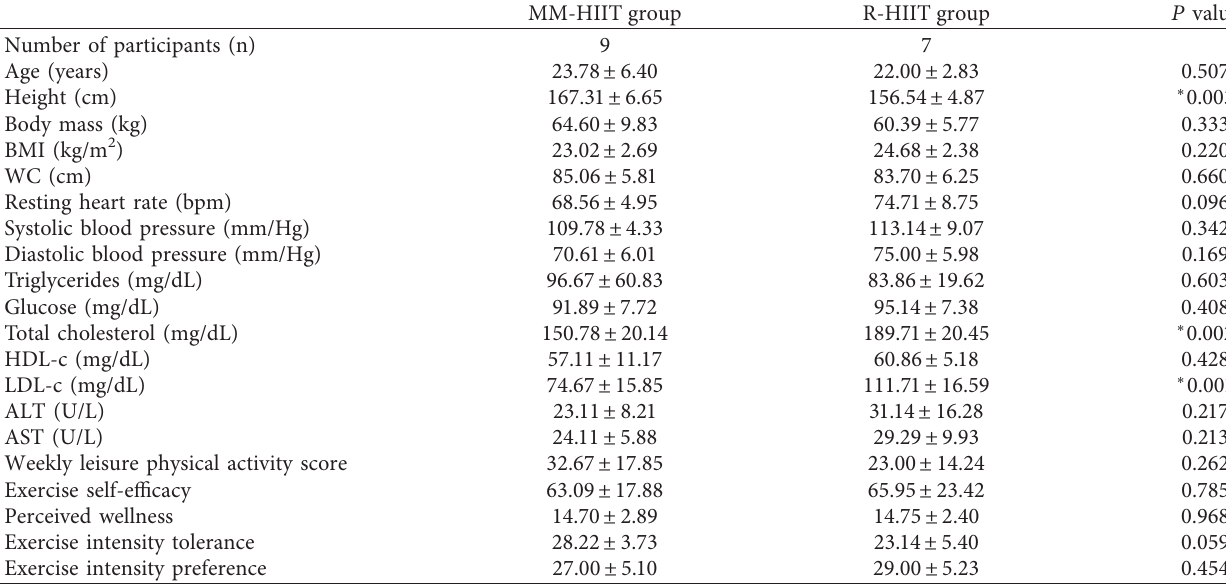
Table 1: Participant descriptive statistics between groups at